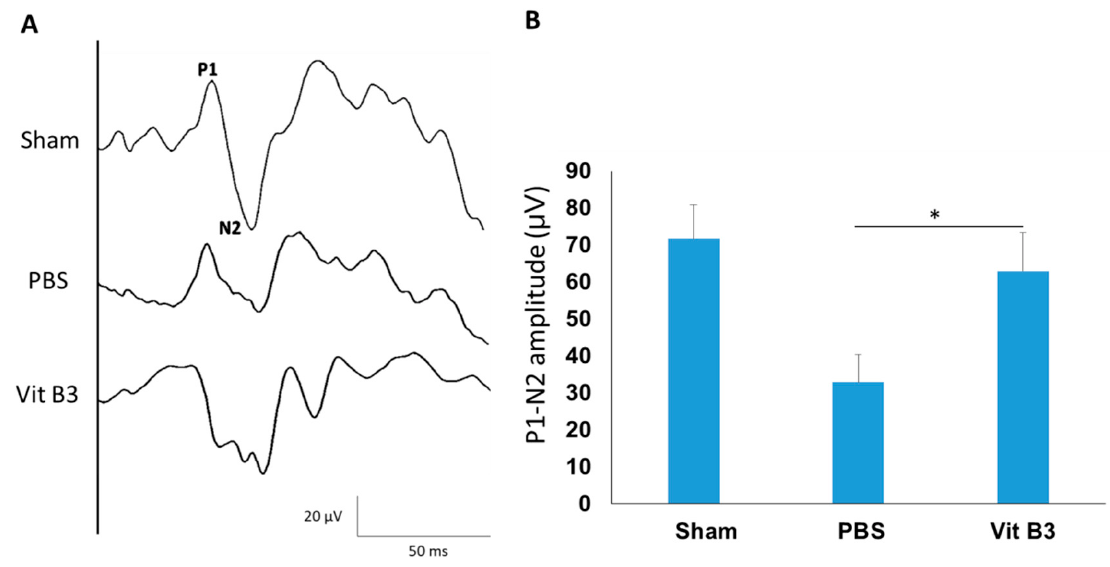
Figure 1. The fVEP assessments showed a significant improvement in the functional visual circuitry 28 days following vitamin B3 administration. ( A ) Each group included a representation of the fVEP wavelets. ( B ) The quantitative findings demonstrated that the P1-N2 wave amplitude was substantially greater in the vitamin B3-treated group than it was in the PBS-treated group (* p < 0.05; n = 6). Data were presented as mean ± standard deviation (SD). P1, the first positive peak; N2, the second negative